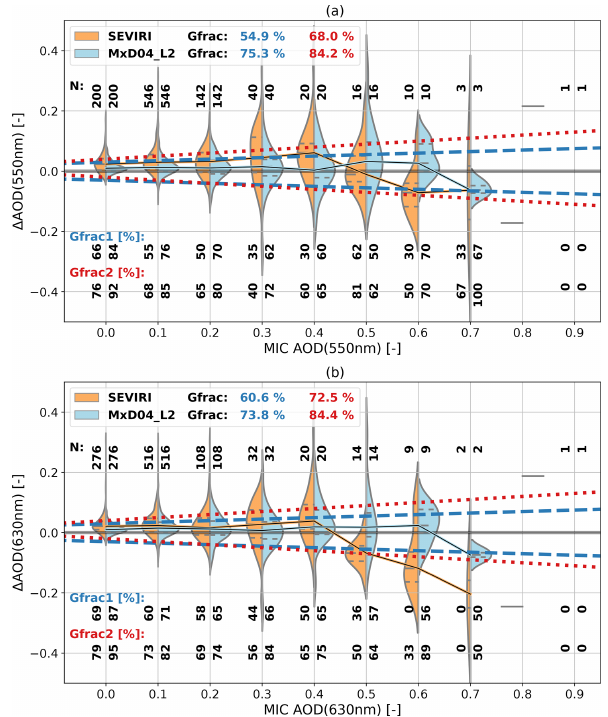
Figure 5. Same as Fig. 4 but only using MIC as a reference dataset. The comparison is presented for AOD at 550nm (a) and 630nm (b) . As an additional constraint, availability of data from both the SE- VIRI and MODIS datasets is